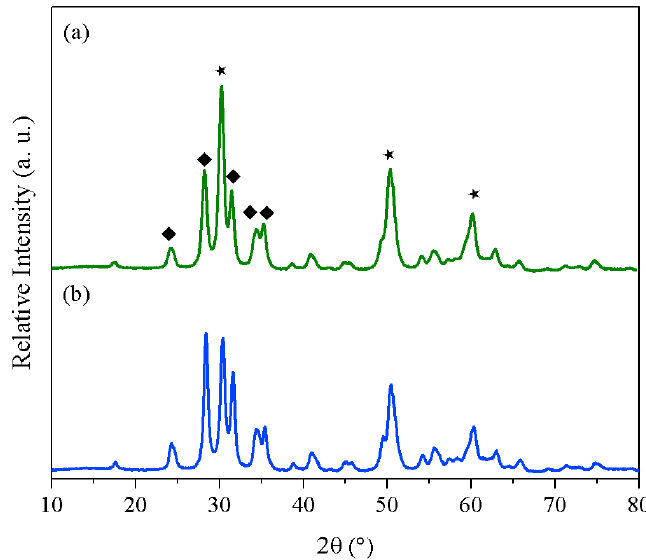
Figure 3. XRD diffraction patterns of synthesized zirconia supports. ( a ) Sol-gel route, ( b ) Co-precipitation route. ZrO 2 Monoclinic phase: ( (cid:7) ), ZrO 2 Tetragonal phase: ( (cid:70) ). Table 1. Phase composition of zirconia supports.